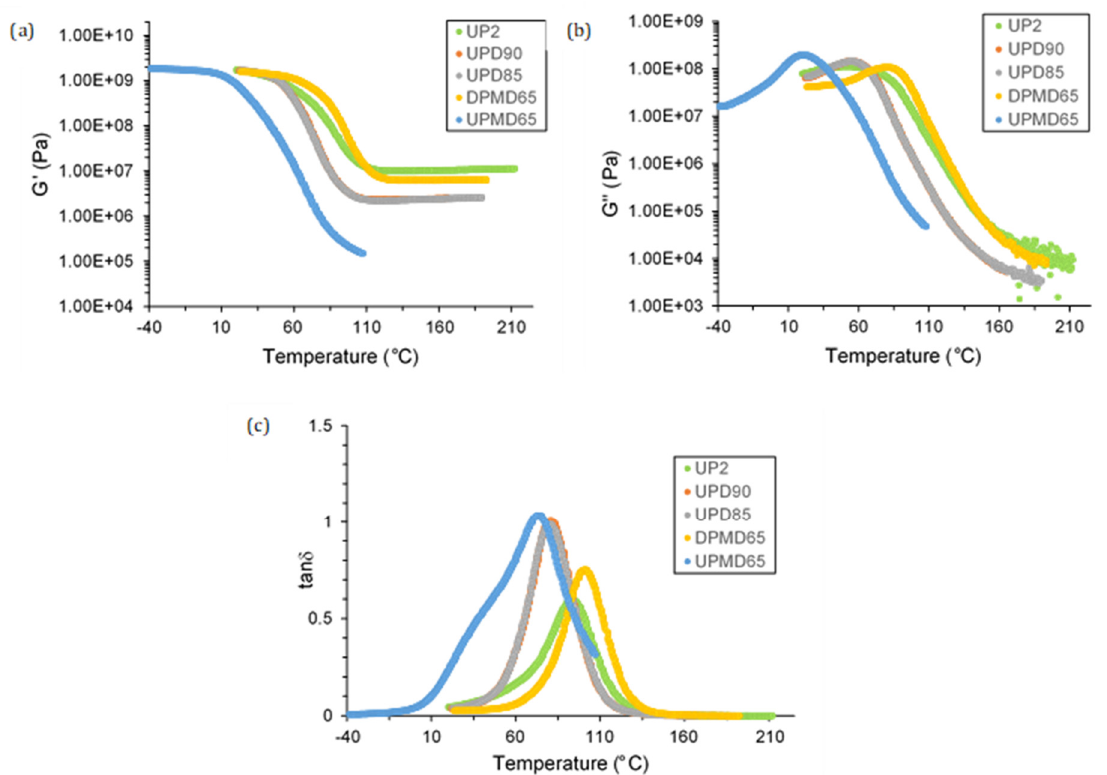
Figure 5. ( a ) Storage modulus; ( b ) loss modulus; ( c ) tan δ of